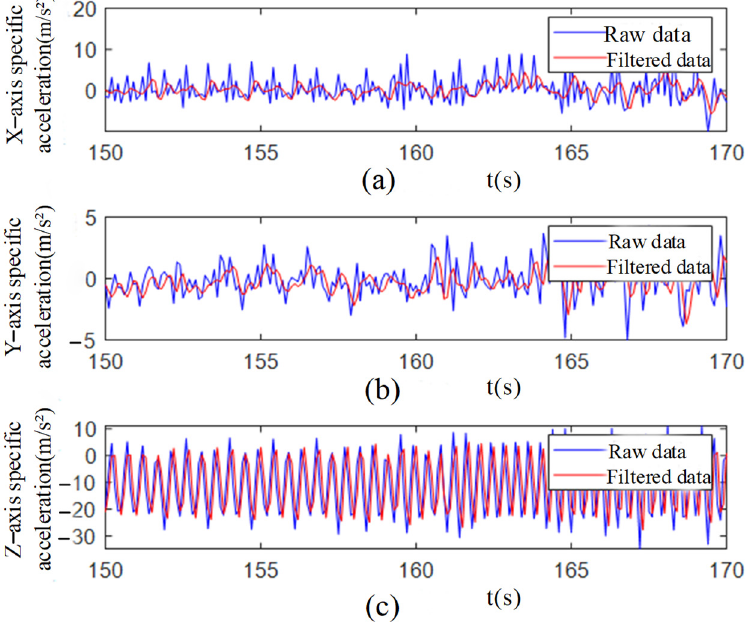
Table 1. Data comparison table before and after sensor calibration.